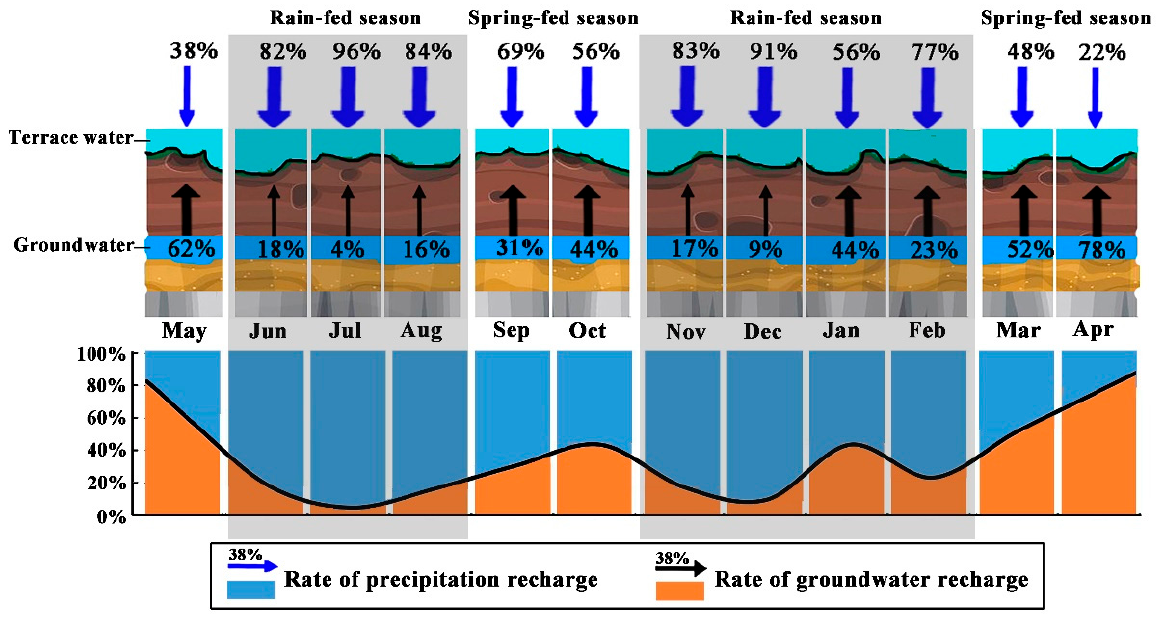
Figure 7. Temporal features on terrace water under the influence of recharge.